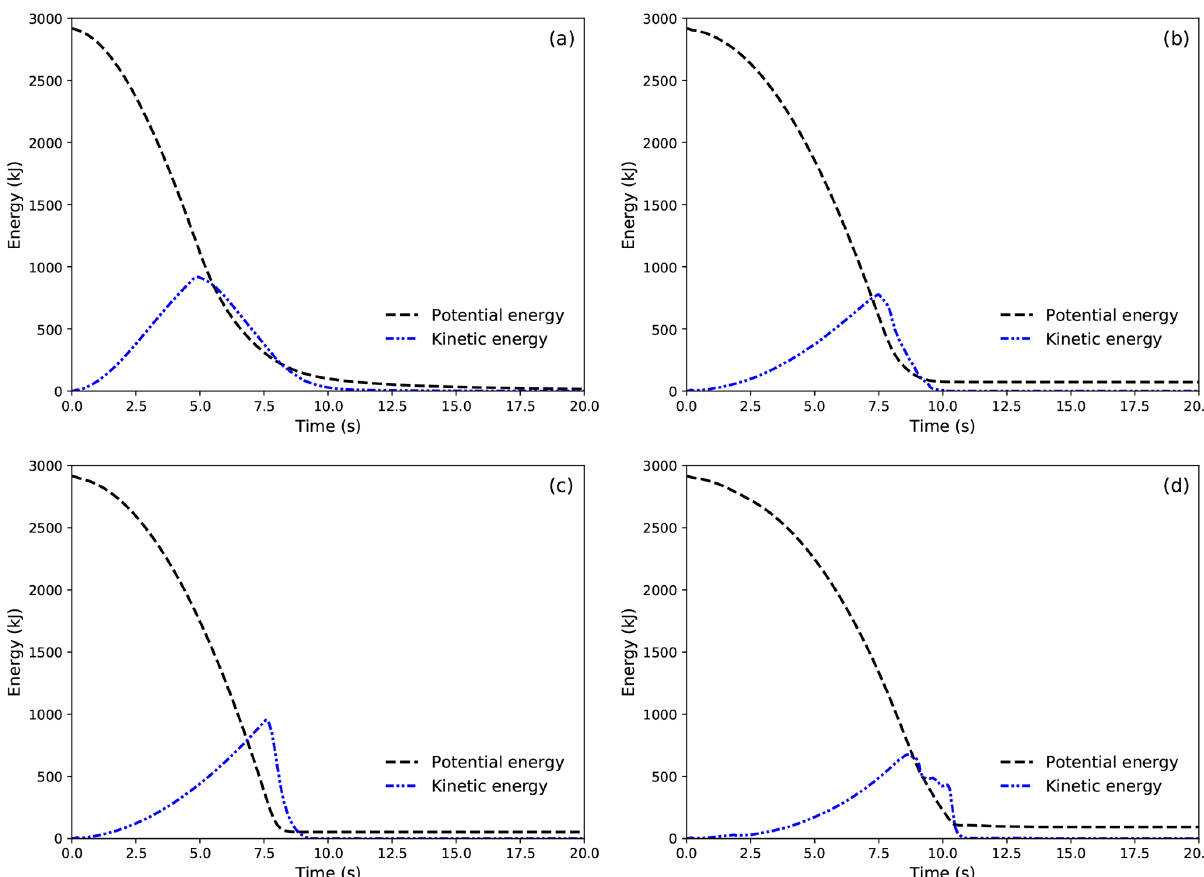
Figure A1. Evolution of potential and kinetic energy of the flows in the four typical flow regimes. (a) Cold dense; (b) warm shear; (c) warm plug; (d) sliding slab.